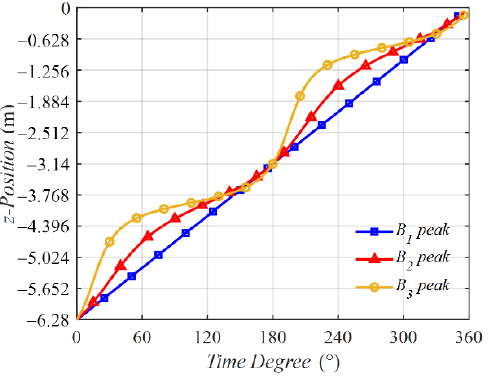
( , ) B z t ( , ) B z t ( , ) B z t , 2 , and 3 varying with the time